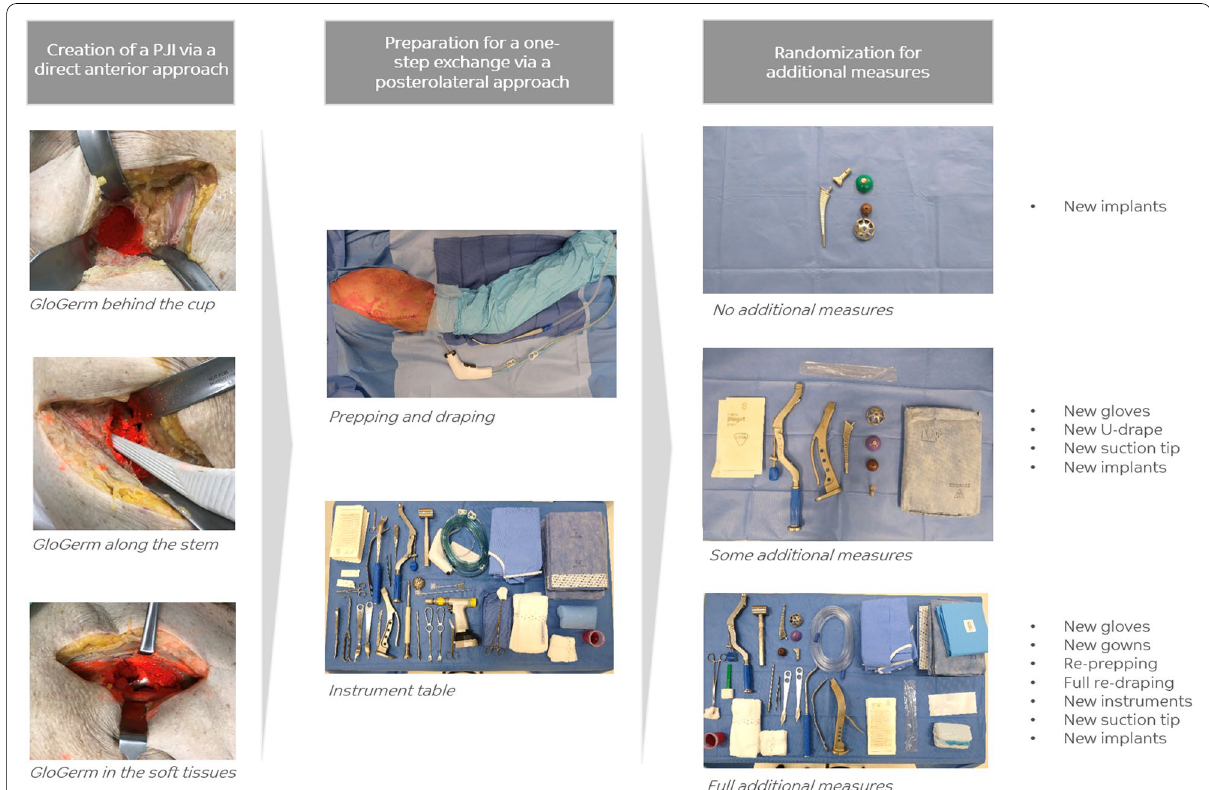
Fig. 2 Simulating an infected Total Hip